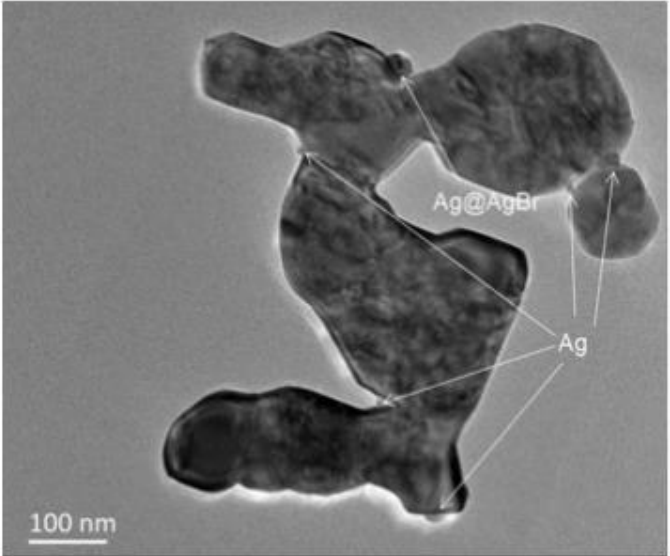
Figure 13. TEM image of Ag@AgBr/ZnO.